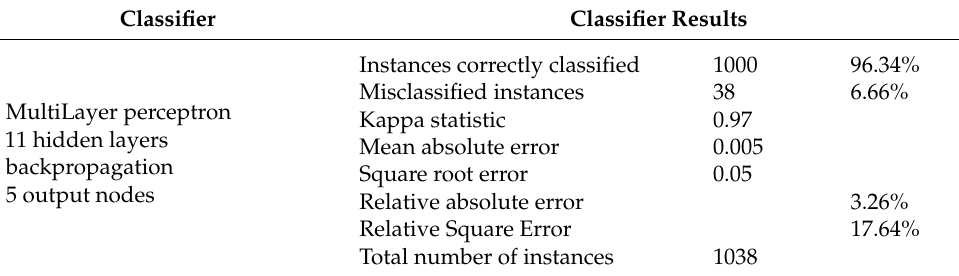
Table 11. Classification of the six attributes with the evaluator classifier attribute